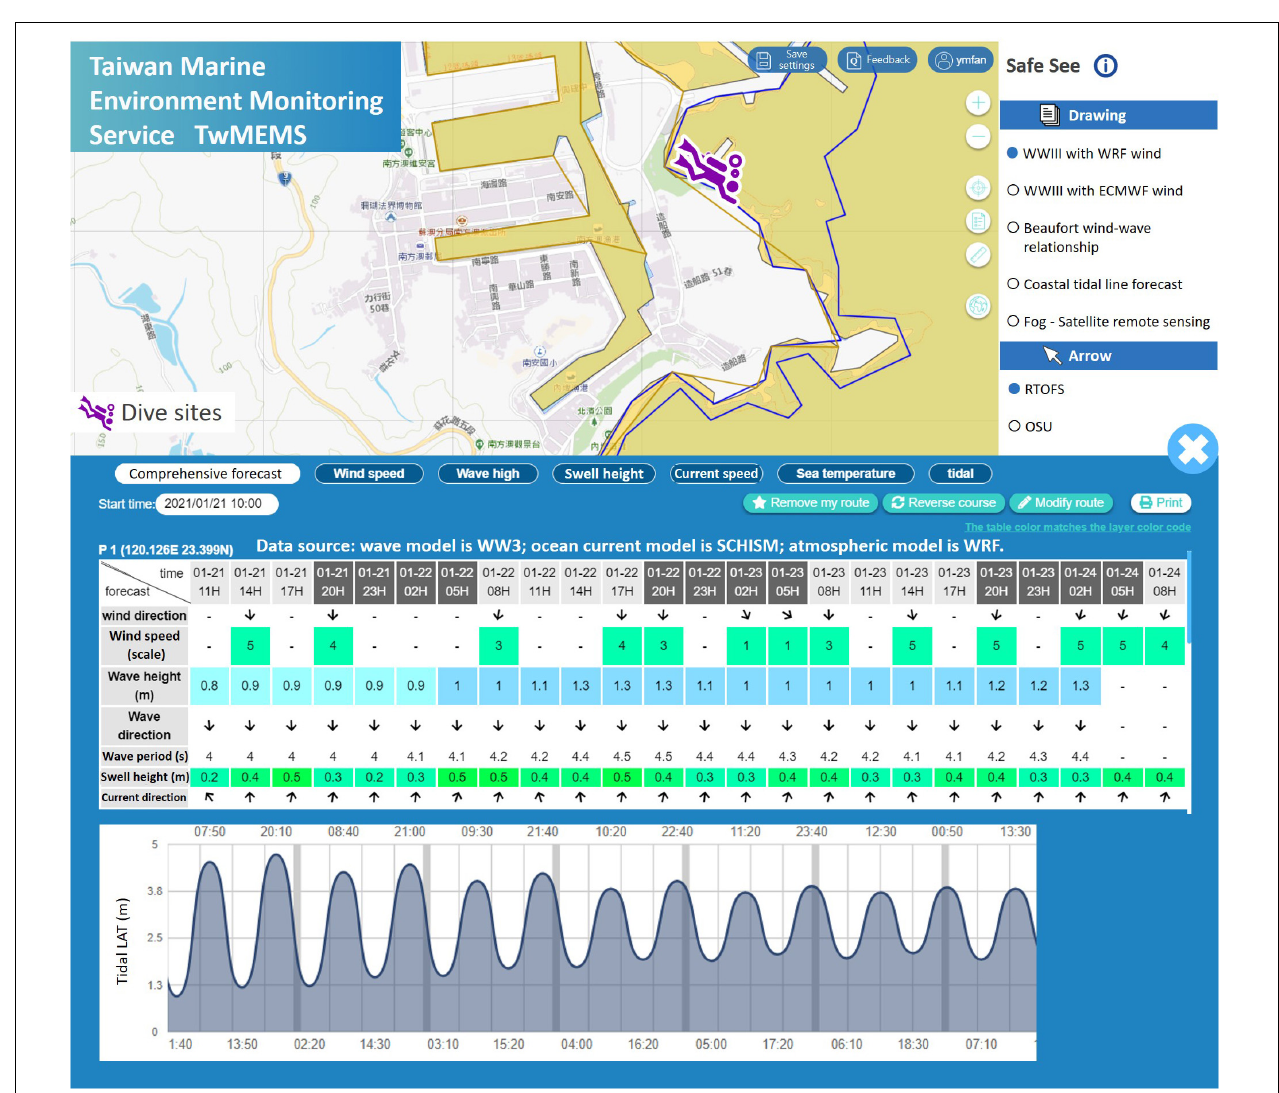
FIGURE 5 | Snapshot of the services for the divers. All data are presented for the next 72 h. The tidal changes that are important for divers are directly shown in the service